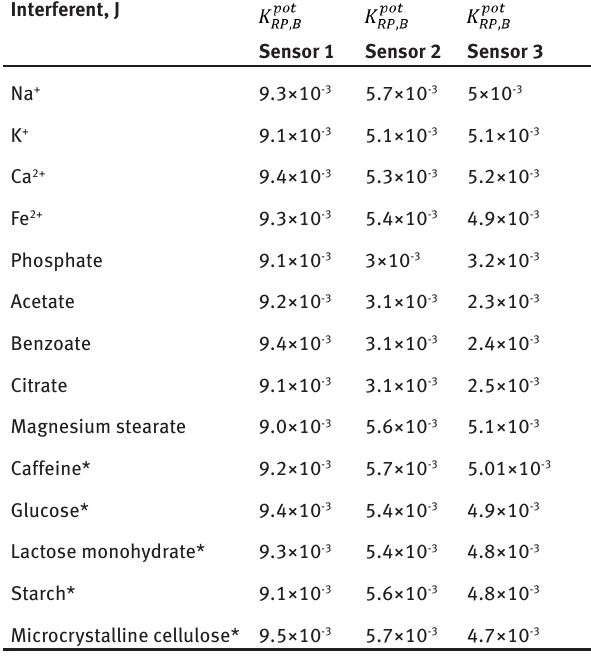
Table 1 : Selectivity coefficients of the PR - PVC